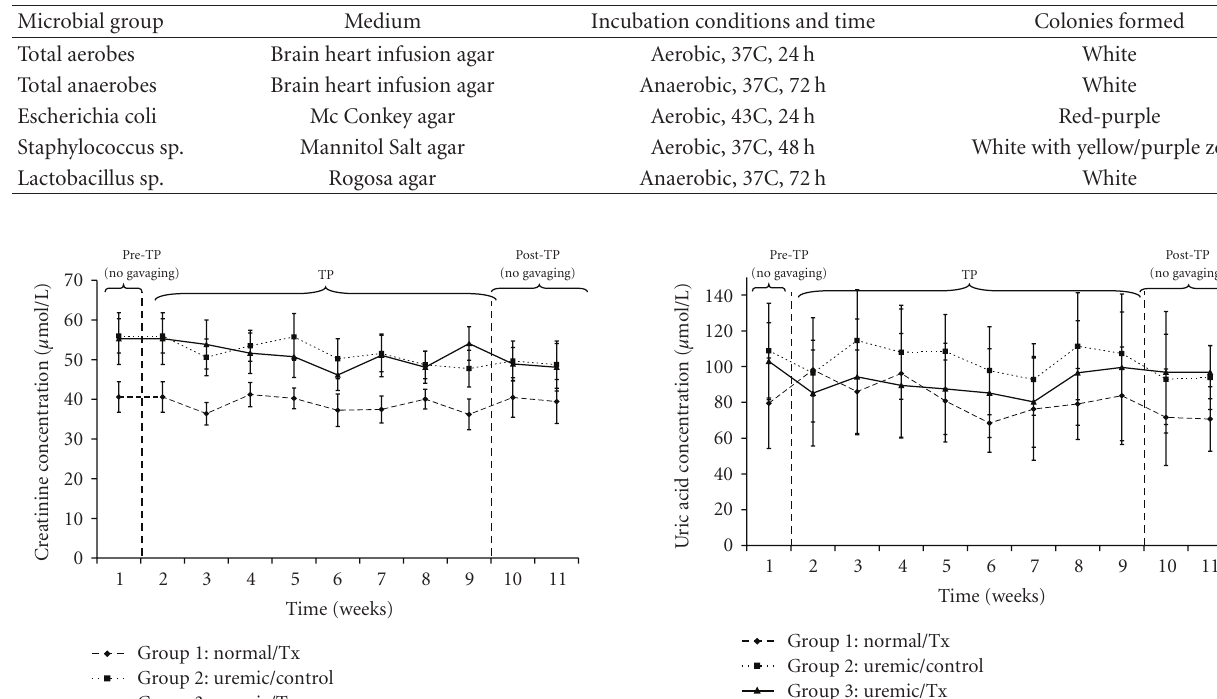
Table 1: Media and incubation conditions used for enumeration of representative microbes in the human large intestine.